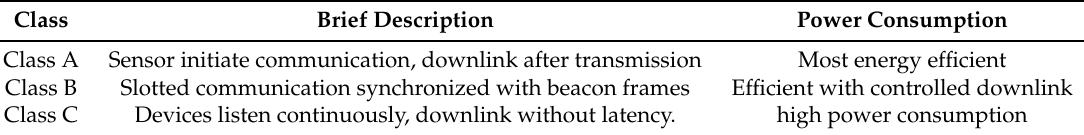
Table 1. LoRaWAN class comparison.